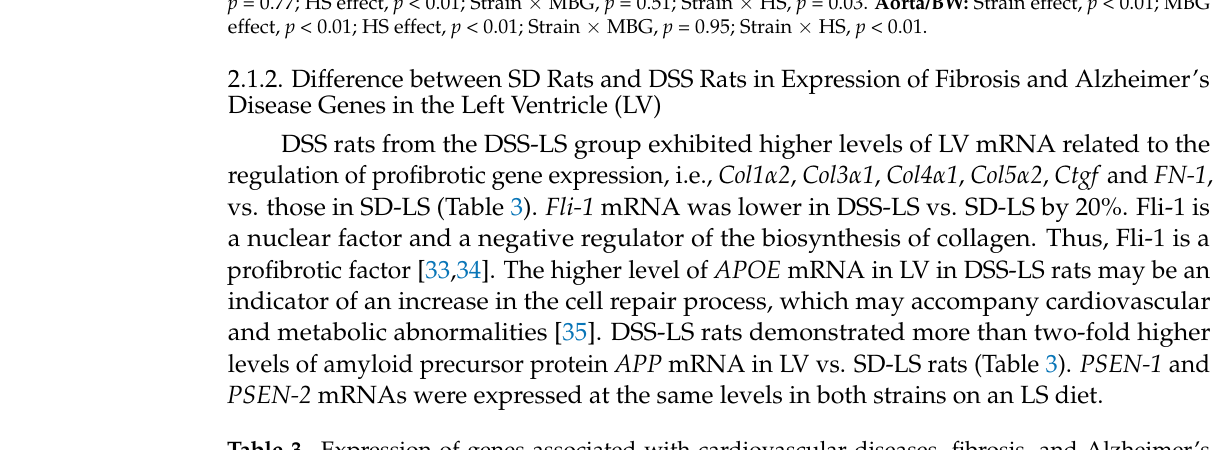
Table 3. Expression of genes associated with cardiovascular diseases, fibrosis, and Alzheimer’s disease in left ventricles from Dahl salt-sensitive rats in comparison to Sprague–Dawley rats on an LS diet (by qPCR